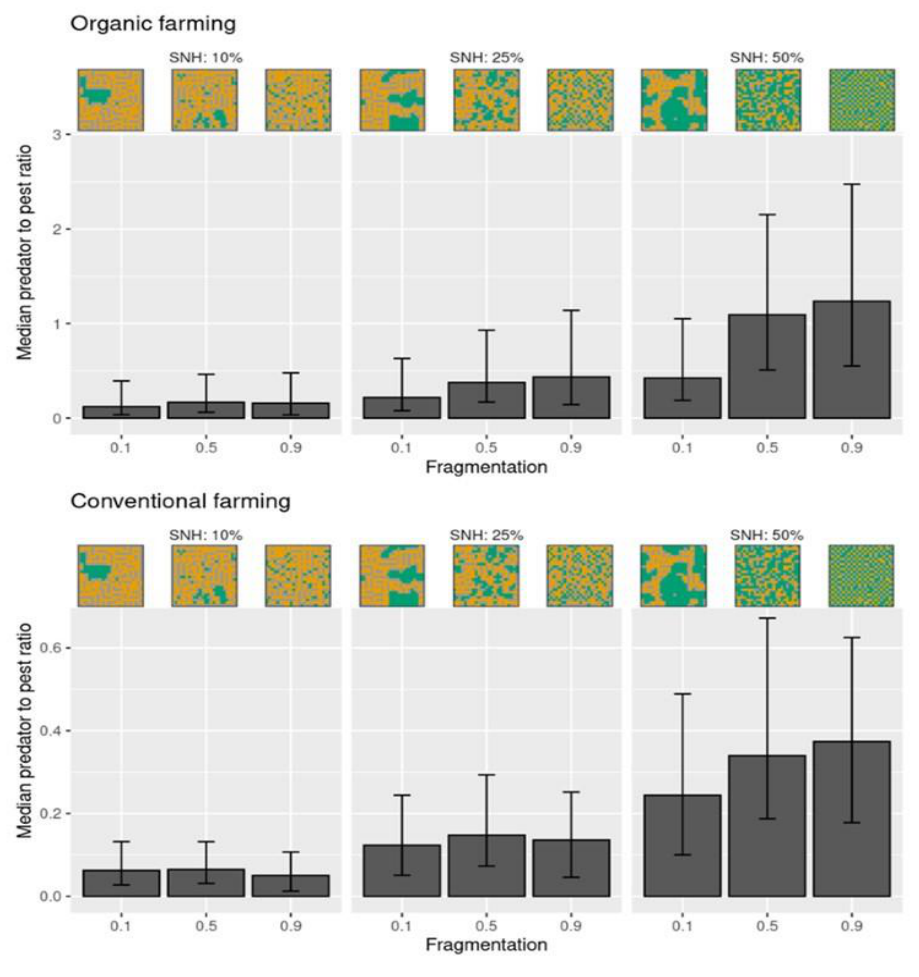
Figure 5 - Median Predator to pest ratio at t=50 for the nine types of initial landscapes, in organic fields (upper) and conventional fields (lower). Error bars represent the first and third quartiles over all scenarios and parameter values. Examples of landscape contexts (combinations of fragmentation and percentage of SNH) are provided for illustration. Note that y-axes are on different